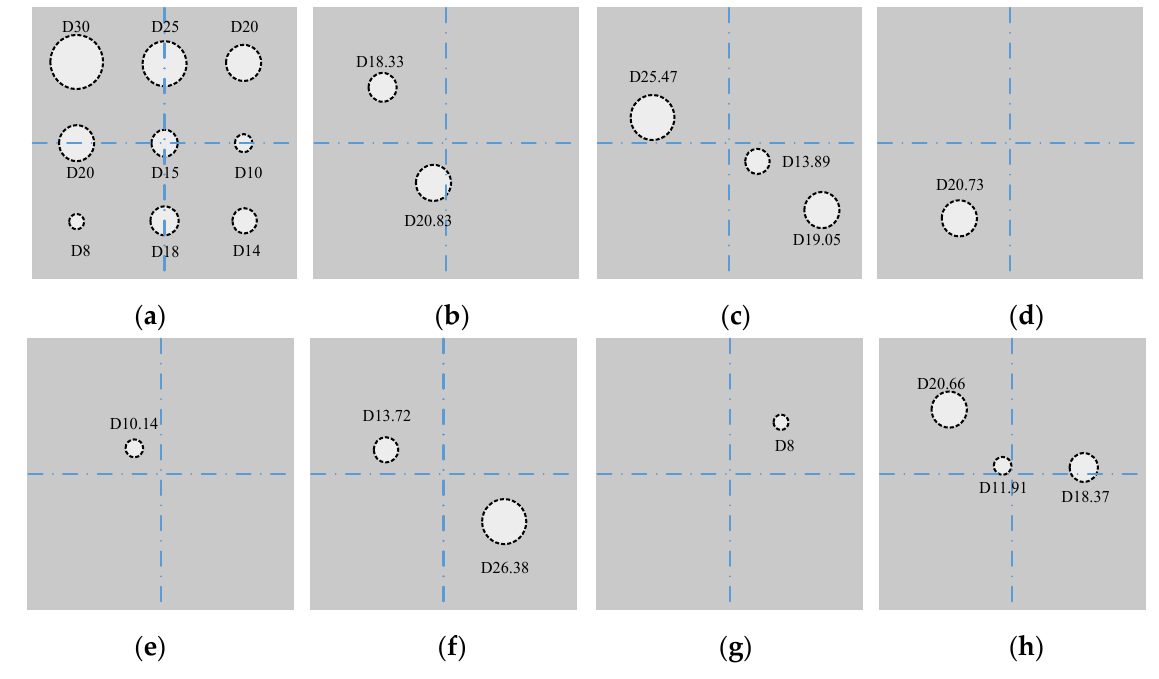
Figure 3. Eight simulation specimens (units: mm): ( a ) aluminum; ( b ) honeycomb; ( c ) PVC foam; ( d ) epoxy carbon; ( e ) resin epoxy; ( f ) glass; ( g ) E glass fiber; ( h ) ABS thermoplastic.